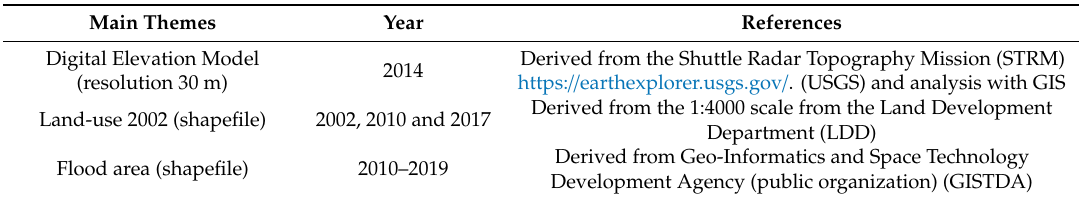
Table 1. Data layers used in this